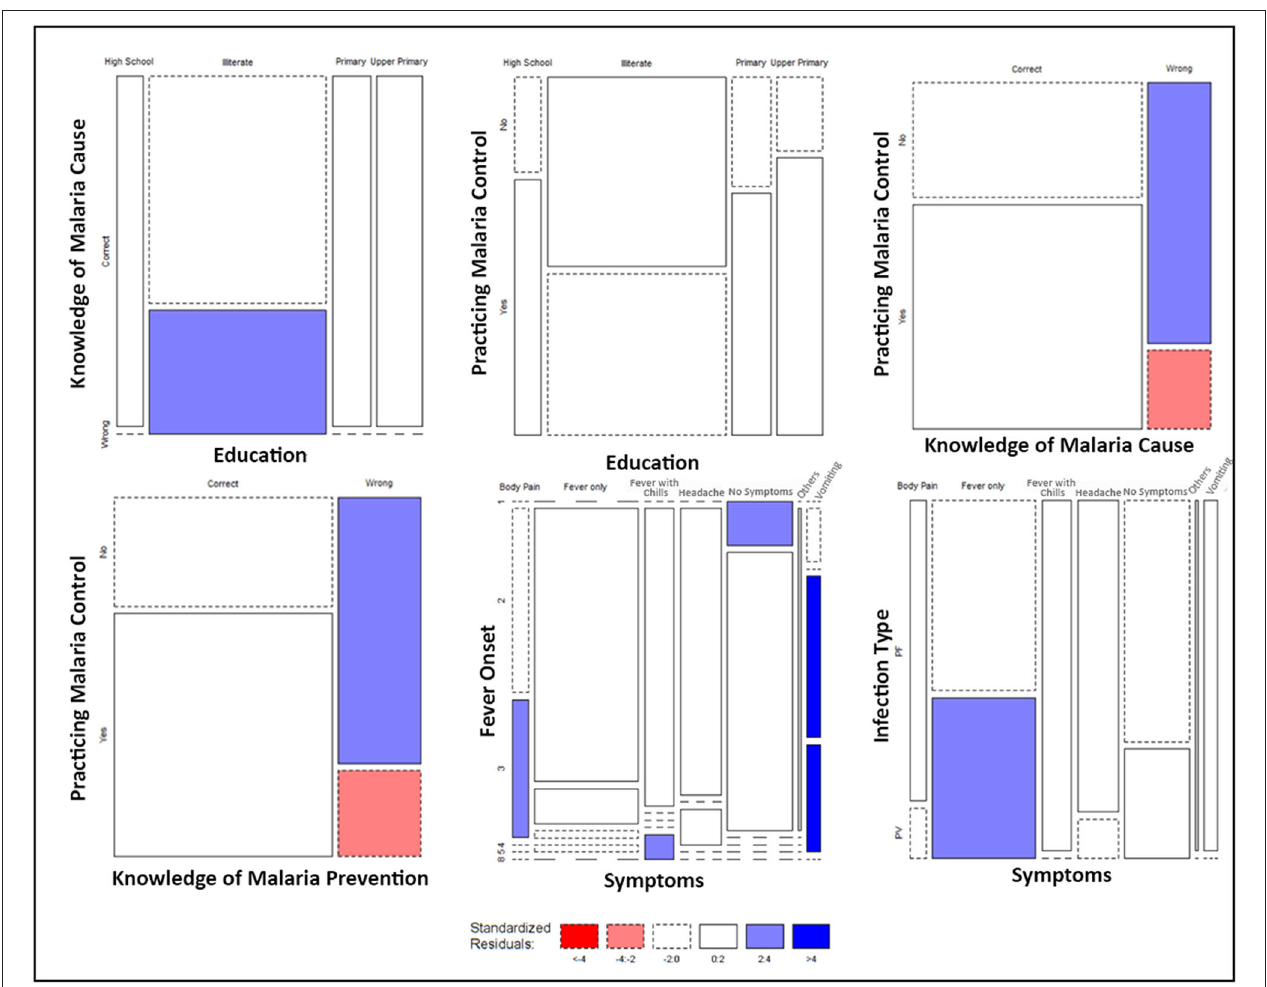
FIGURE 6 | Mosaic Plots of significantly associated KAP variables. Width of the boxes indicates the proportion of respondents, whereas the height of the boxes indicates the proportion of each row variable. Colors indicate the range of the standard residuals estimated by calculating the difference between the observed values and expected values due to random